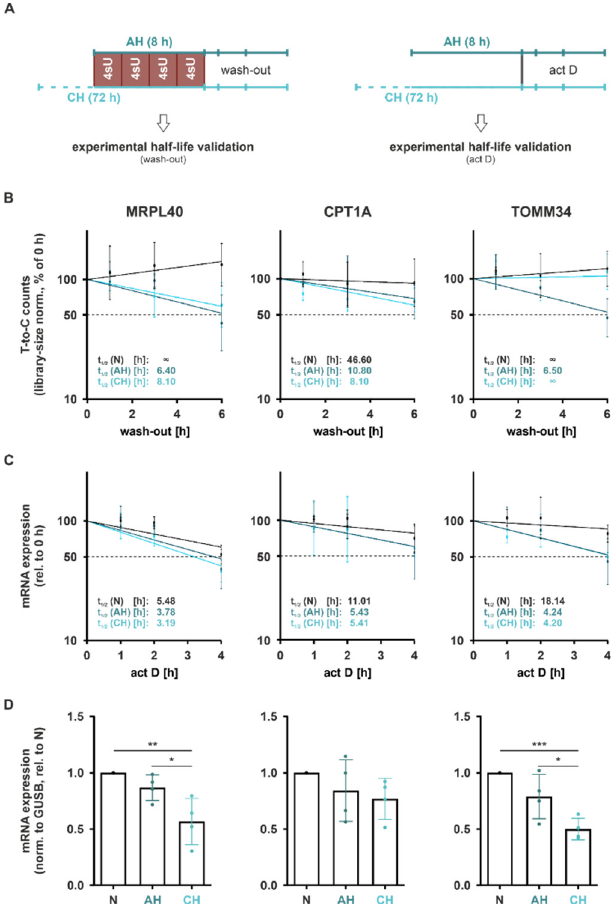
Figure 7. Validation of altered functional mRNA stability under hypoxia. ( A ) THP-1 cells were incubated under hypoxia (1% oxygen) for 8 h (acute hypoxia, AH) or 72 h (chronic hypoxia, CH), or under normoxia. For experimental validation of half-life changes, cells were supplemented with 4 × 30 µ M 4-thiouridine (4sU) during the last 8 h, followed by a wash-out with excess uridine of up to 6 h and RNA sequencing ( left ). Alternatively, transcription was blocked by the addition of actinomycin D (2.5 µ g/mL; act D) at the end of the incubations, and mRNA expression was followed for up to 4 h by RT-qPCR analyses ( right ). ( B ) mRNA stability of selected functional DSR was determined by wash-out analyses. Library-size corrected T-to-C counts were normalized to 0 h wash-out. ( C ) mRNA stability of selected functional DSR was further analyzed by following mRNA levels after transcriptional blockade. mRNA expression was assessed by RT-qPCR. Half-lives (t 1/2 ) were determined by linear regression ( B , C ). ( D ) Total mRNA expression of selected functional DSR after AH or CH as compared to N was assessed by RT-qPCR. Residuals were tested for normality using Shapiro–Wilk test, and one-way ANOVA with Tukey’s multiple comparison test was performed ( n ≥ 3; * p < 0.05, ** p < 0.01, *** p <